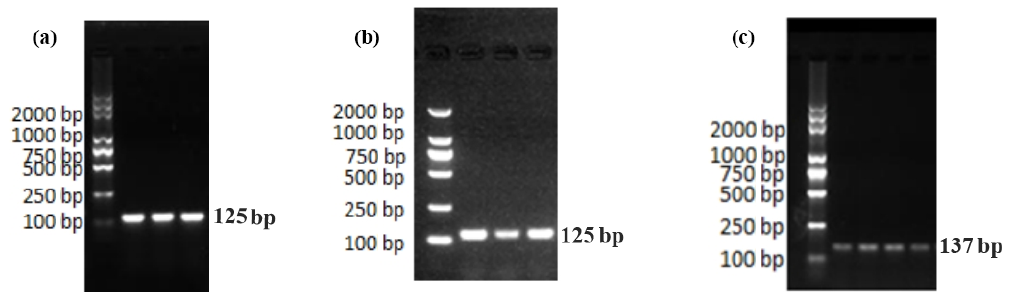
Figure 1. PCR amplification of GAPDH (a) , EPHA4 (b) , and Ephrin A3 (c) .